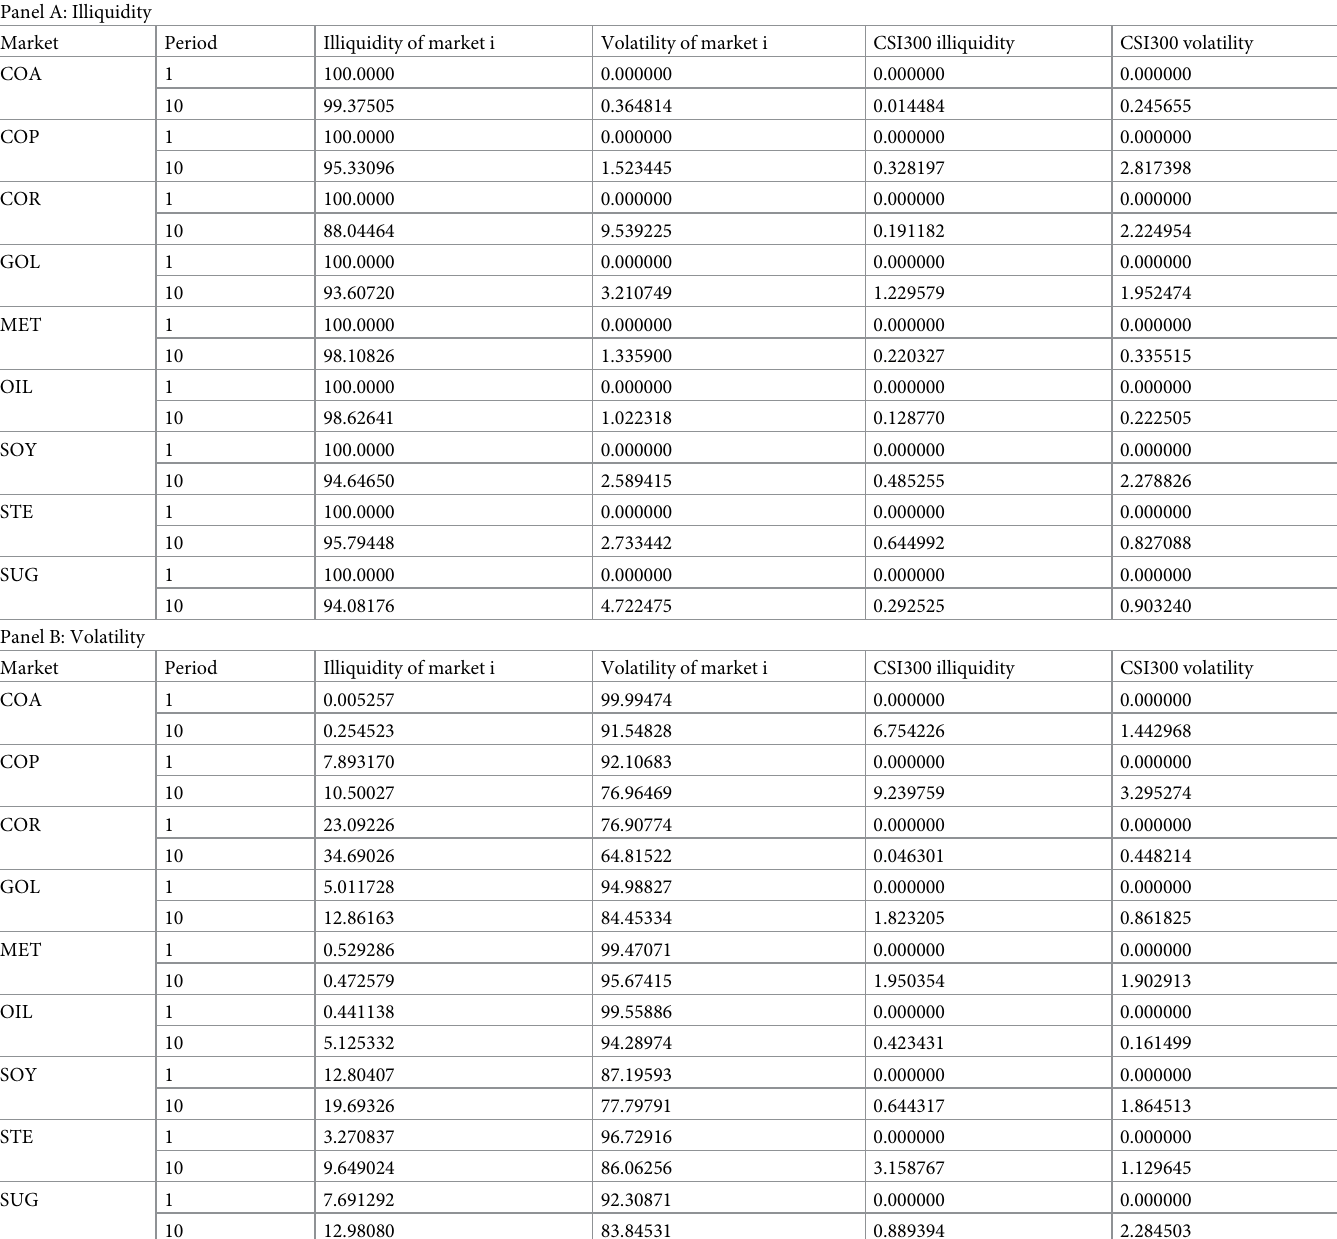
Table 6. Variance decomposition of market i illiquidity to own and other market illiquidity and volatility. This table presents the variance decompositions computed from a six-variable VAR for market i and CSI300 market. All variables are adjusted for deterministic time series variations. Illiquidity is measured using the Amihud mea- sure for each stock and is averaged across stocks for each market. We choose the number of lags based on the SC and HQ criteria. The sample runs from January 1, 2010 to March 22,